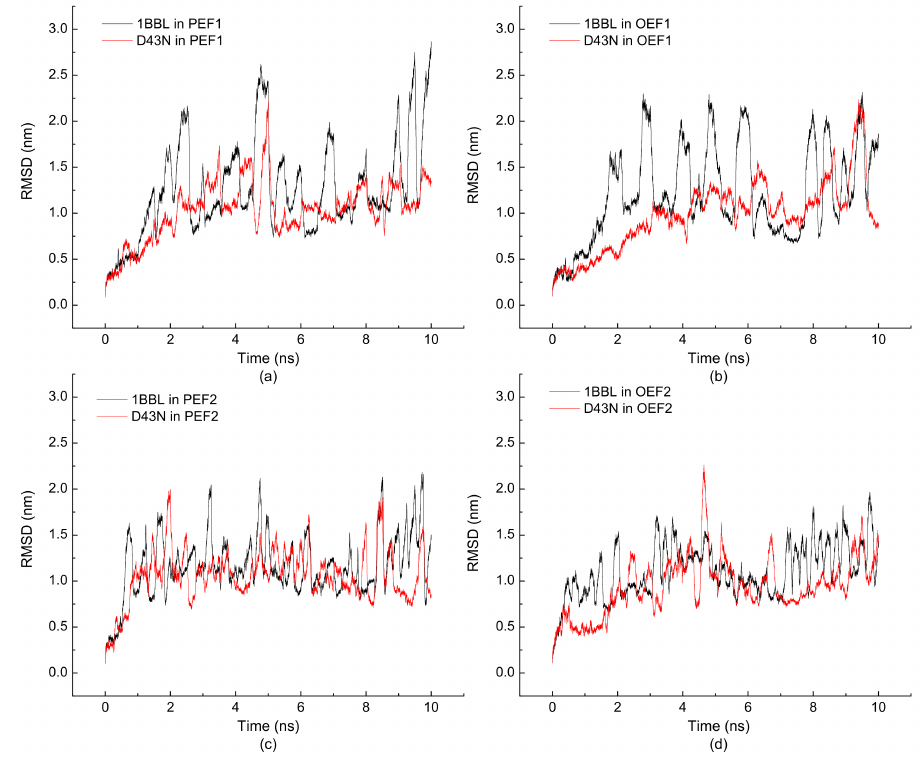
Figure 7. (Color online) Time evolution of the root mean square deviation (RMSD) of the protein 1BBL and its mutant D43N exposed in the ( a ) pulsed electric field with a frequency of 1000 MHz, ( b ) oscillating electric field with a frequency of 1000 MHz, ( c ) pulsed electric field with a frequency of 2000 MHz and ( d ) oscillating electric field with a frequency of 2000 MHz,